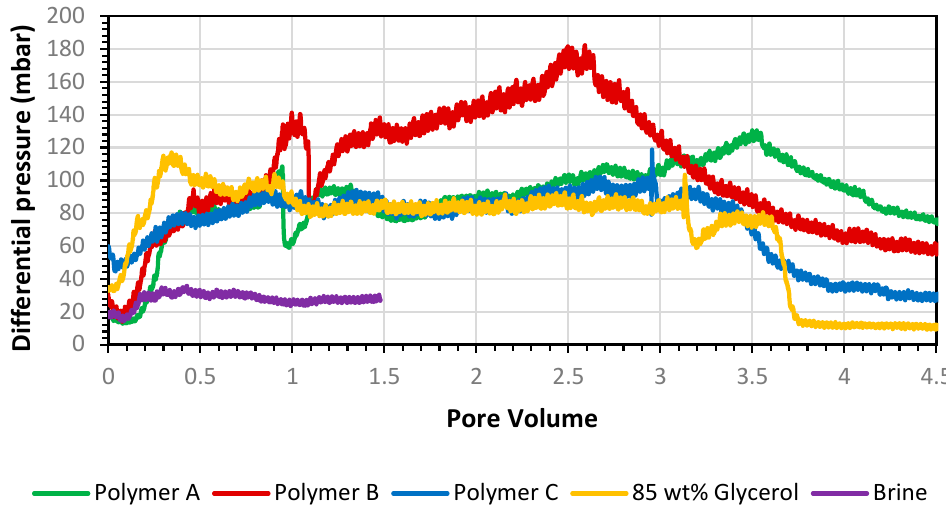
Figure 6. Heterogenous micromodels differential pressure response obtained from secondary-mode flooding for all cases.